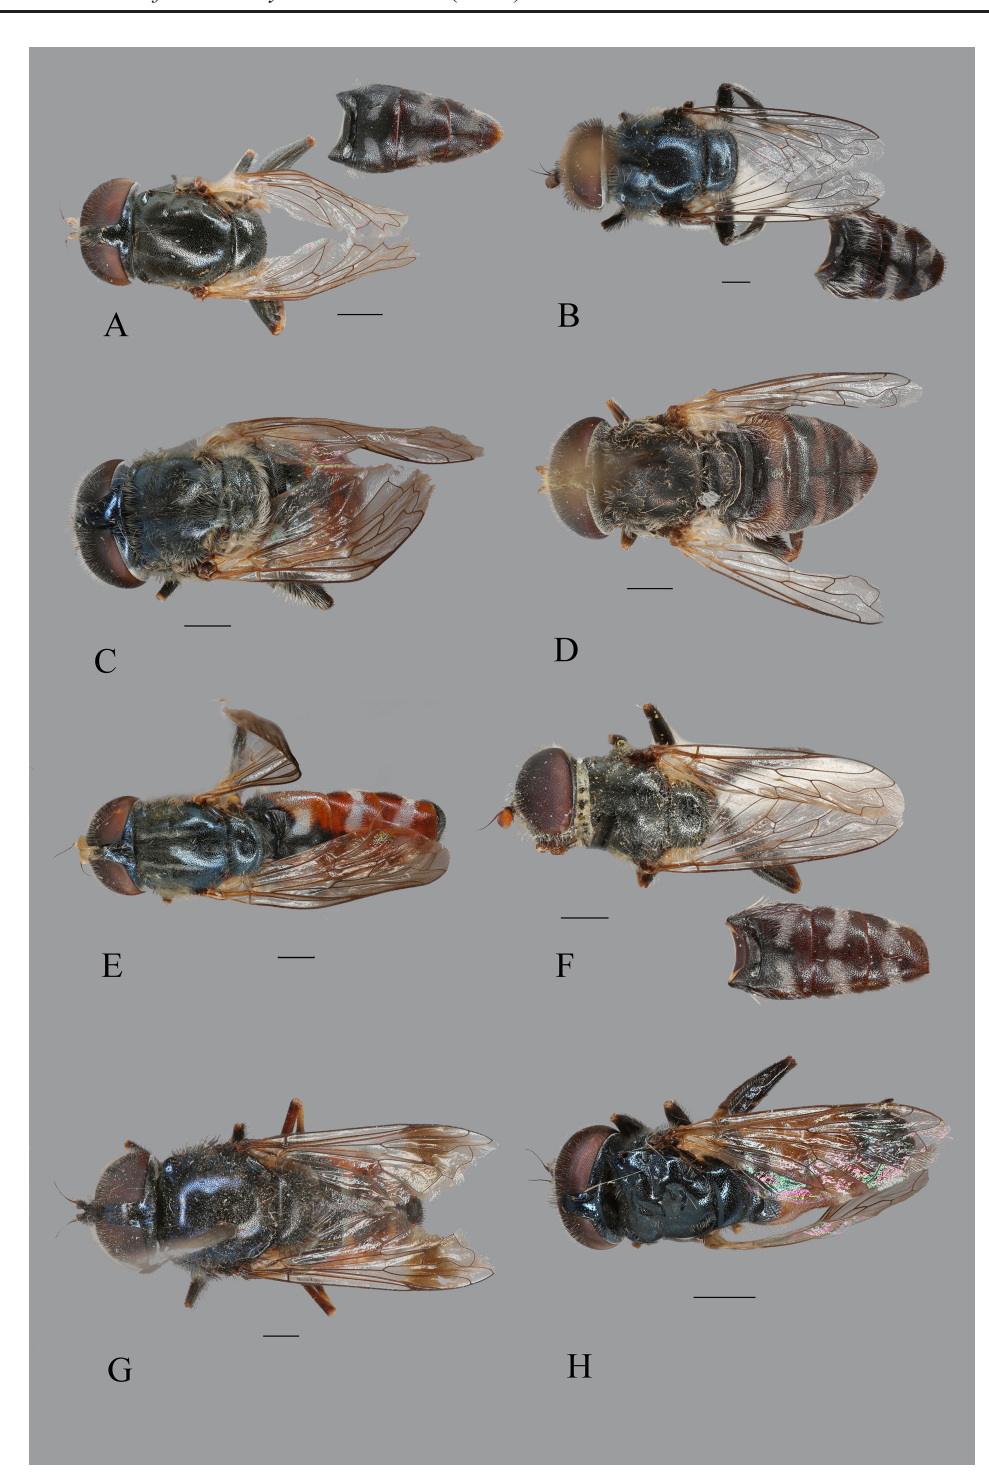
Fig. 4. Adult habitus, ♂, dorsal view. A . Eumerus sp., Khash, Iran (HMIM). B . E. hissaricus Stackelberg, 1949, Ghoochan, Iran (HMIM). C . E. ovoformus Gilasian & van Steenis sp. nov., holotype (HMIM). D . E. persarum Stackelberg, 1961, Yazd, Iran (JSA). E . E. pilosipedes Gilasian & van Steenis sp. nov., holotype (HMIM). F . E. richteri Stackelberg, 1960, Lar, Iran (HMIM). G . E. tadzhikorum Stackelberg, 1949, Chekab Valley, Iran (JSA). H . E. vallicolus Gilasian & van Steenis sp. nov., holotype (HMIM). Scale bars = 1.0